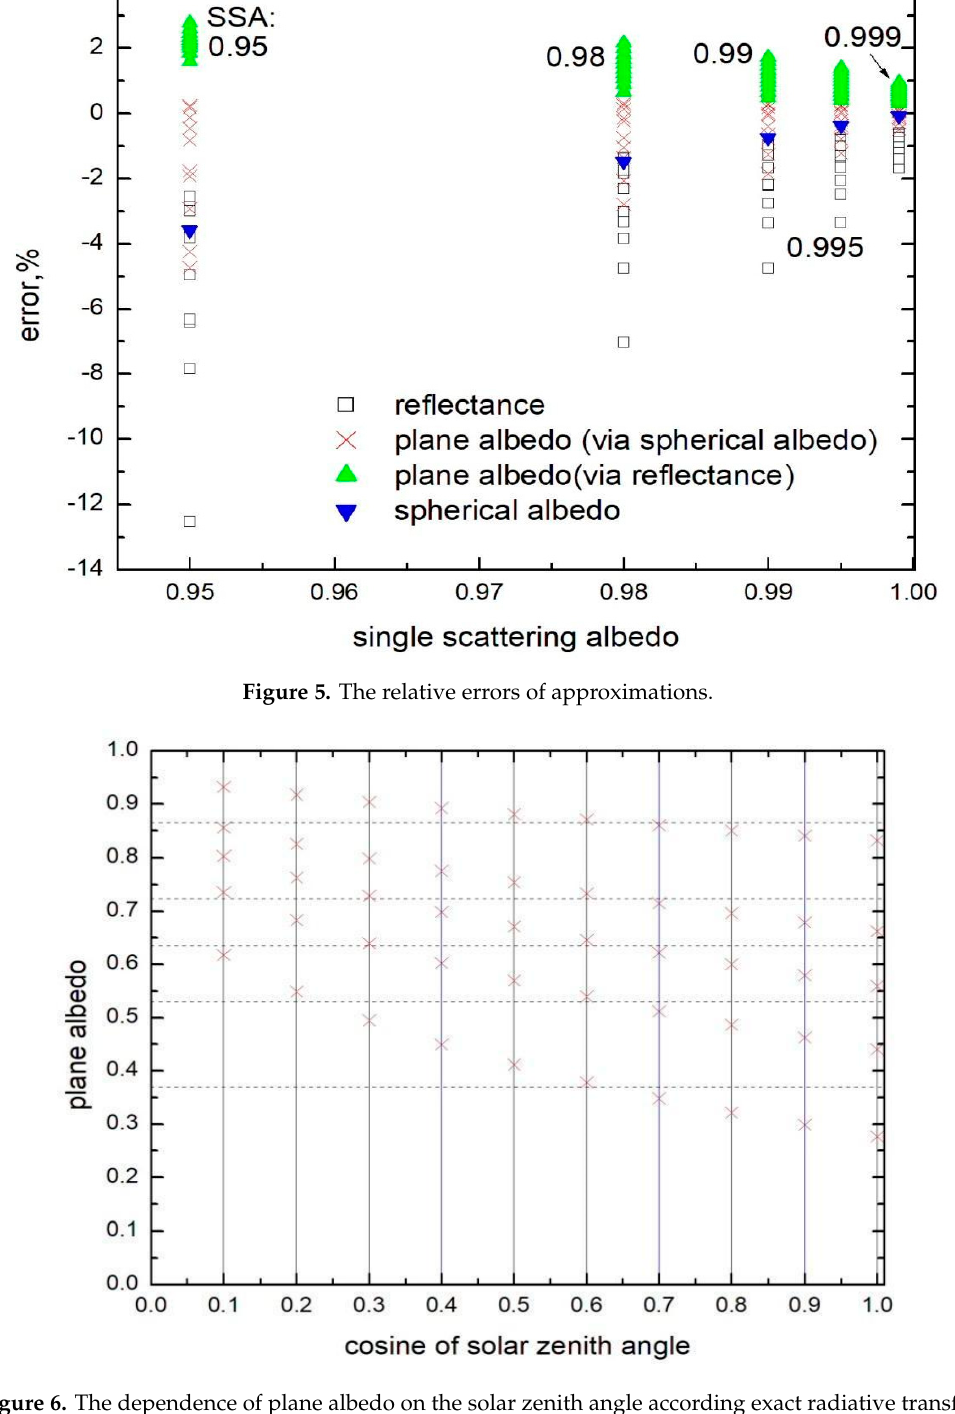
Figure 6. The dependence of plane albedo on the solar zenith angle according exact radiative transfer calculations for various values of single scattering albedo (the same as in Figure 5). The spherical albedo is shown by dashed lines. The spherical albedo coincides with the plane albedo at 𝜇 (cid:2868) = 2/3.